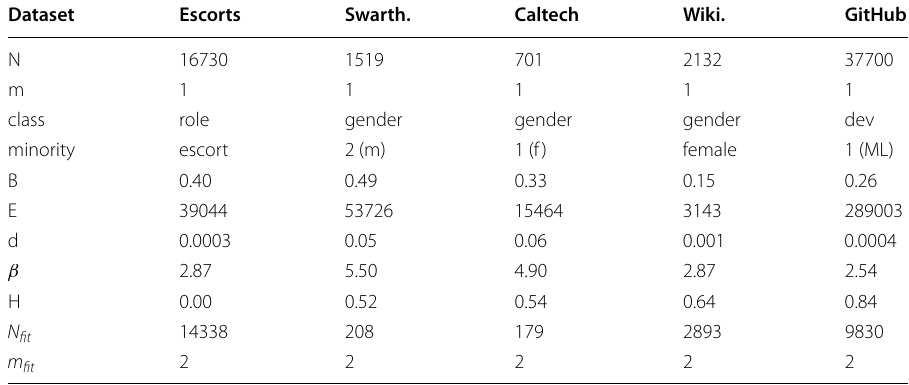
In addition to the properties of interest, we report β , the power‑law exponent of the degree distribution computed as described in Karimi et al. (2018). N fit and m fit represent the number of nodes and minimum degree utilized to generate synthetic networks,